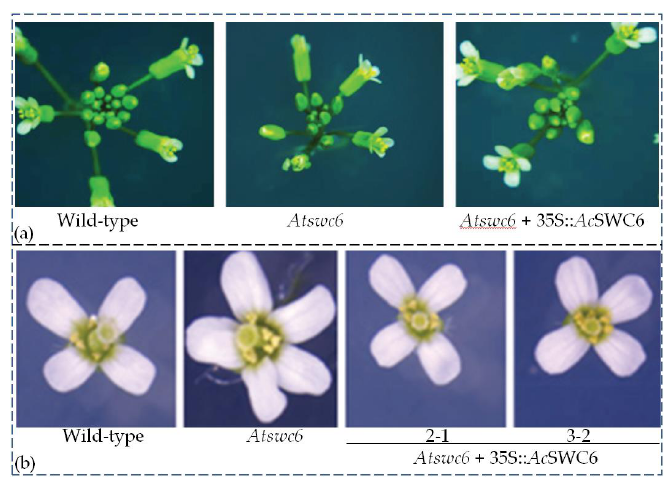
Figure 9. Ac SWC6 rescues the Atswc6 mutant floral architecture. ( a ) Flower architecture phenotype of wild type, Atswc6 , and Atswc6 35S:: Ac SWC6 complemented lines. ( b ) Petal phenotype of wild type, Atswc6 , and Atswc6 35S:: Ac SWC6.